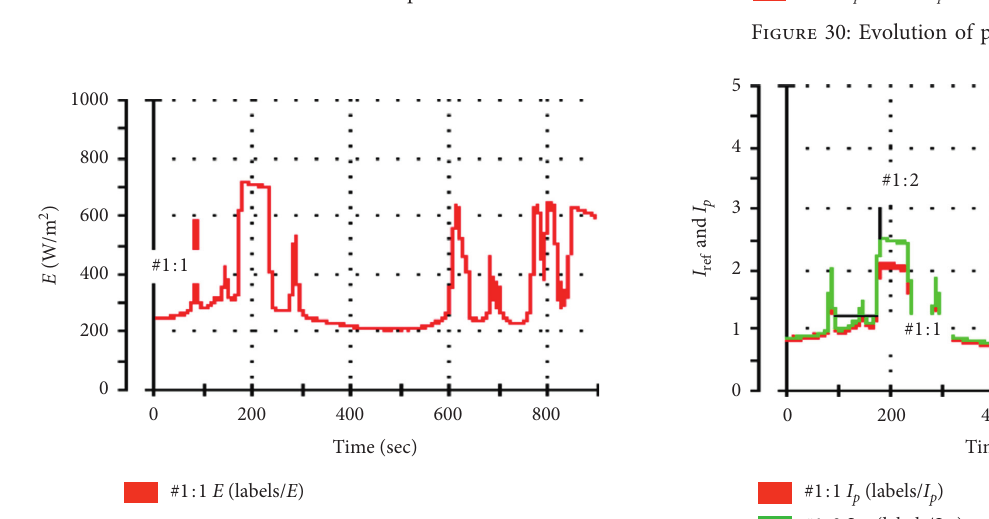
Figure 28: Evolution of solar radiation.